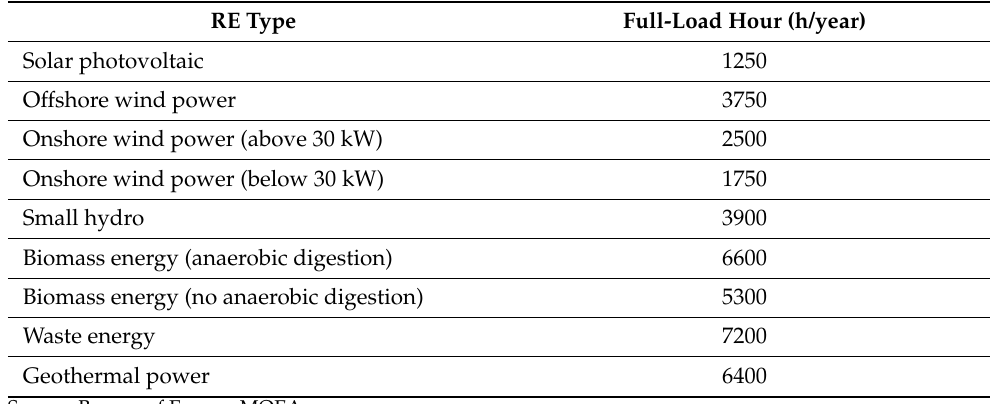
Table 8. RE full-load hour in